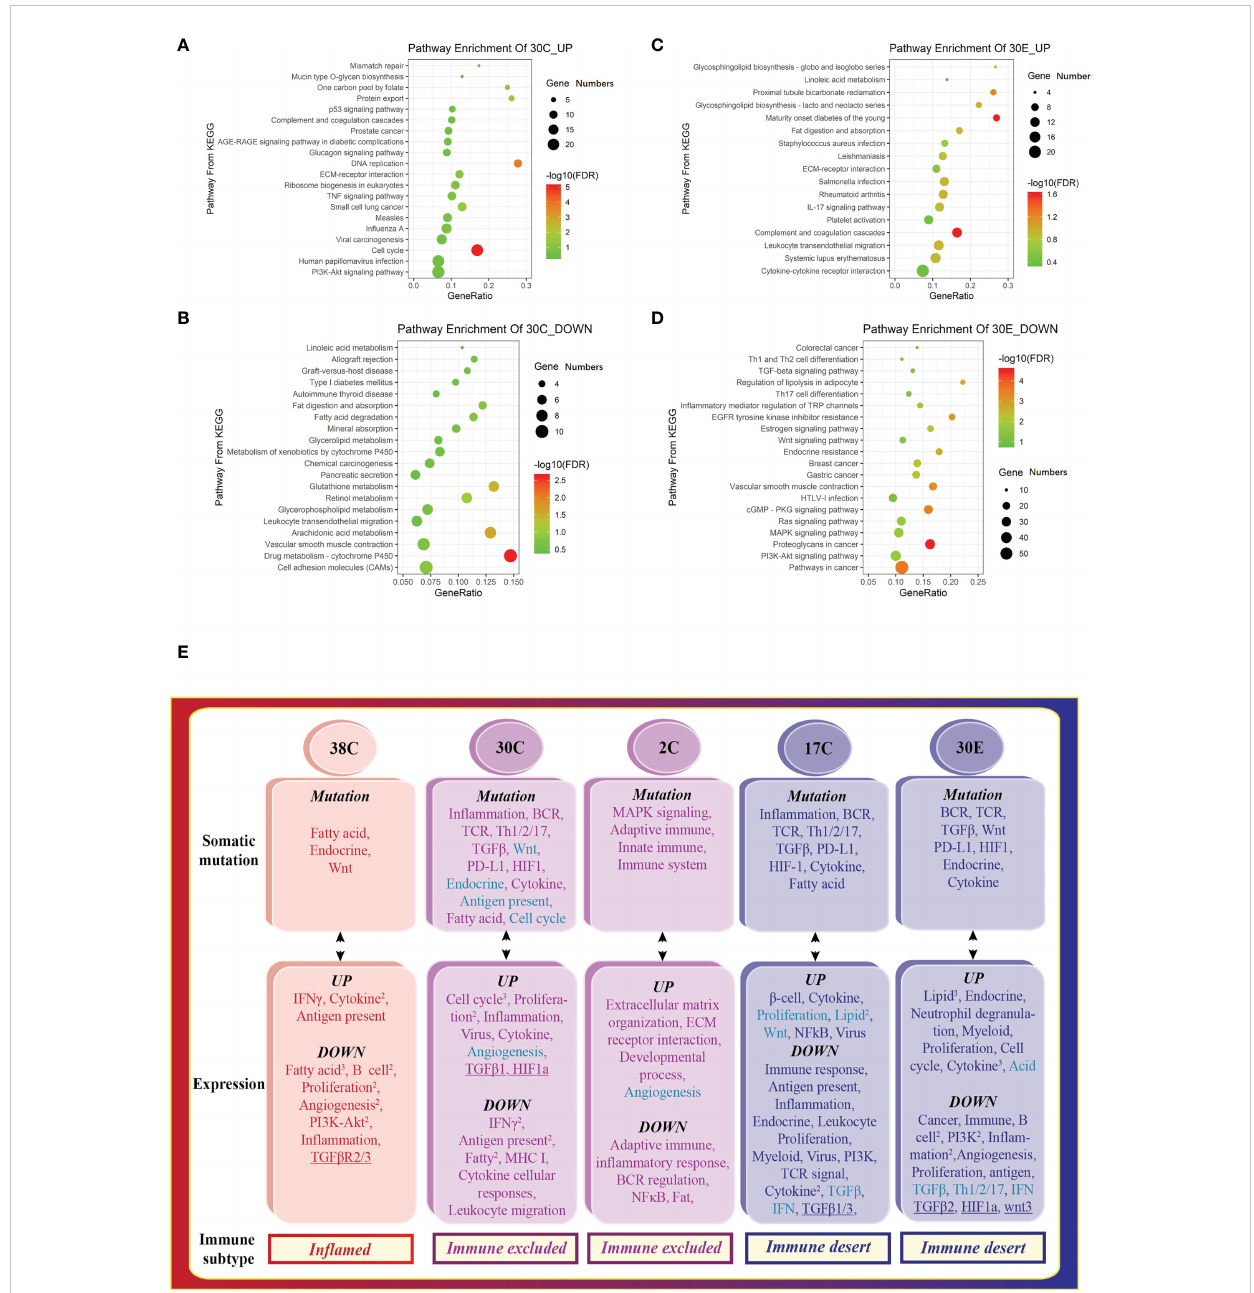
FIGURE 4 The tumors from different organs of the same patient display distinct tumor immune signatures. Scatterplot of enriched Kyoto Encyclopedia of Genes and Genomes (KEGG) pathways of (A) downregulated and (B) upregulated DEGs in colon tumors, indicating the activation of the cell cycle, proliferation, and in fl ammation. Scatterplot of enriched KEGG pathways of (C) downregulated and (D) upregulated DEGs in the endometrial tumor, suggesting the activation of lipid metabolism. 30E — endometrial tumor of patient #30. The vertical axis represents the KEGG pathway. The horizontal axis represents the percentage of DEGs in the total number of genes involved in certain KEGG pathways. The size of the bubble indicates the number of DEGs enriched in this item, and the color of the dots indicates the range of – log10 (FDR). (E) The tumor somatic mutations contribute to the variation of the tumor immune signatures in Lynch syndrome. The mRNA expression patterns that are opposite to somatic mutation pro fi les in different tumors correspond to various tumor immune